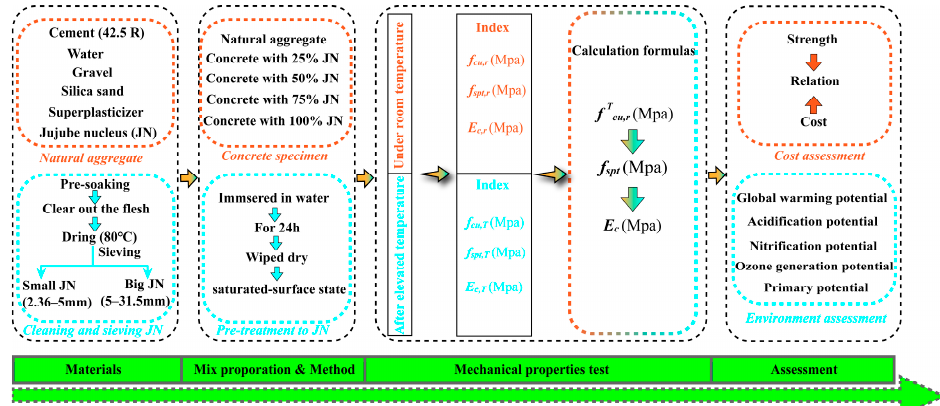
Figure 1. Research flow chart of the experiment.